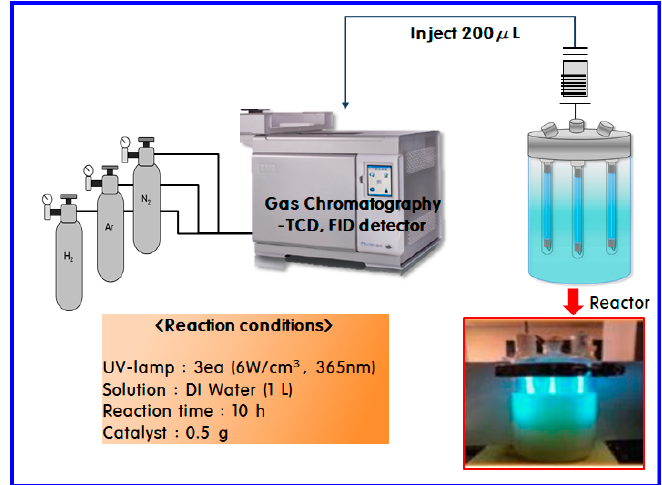
Figure 10. A liquid photoreactor designed in our laboratory for the photocatalytic splitting of water.